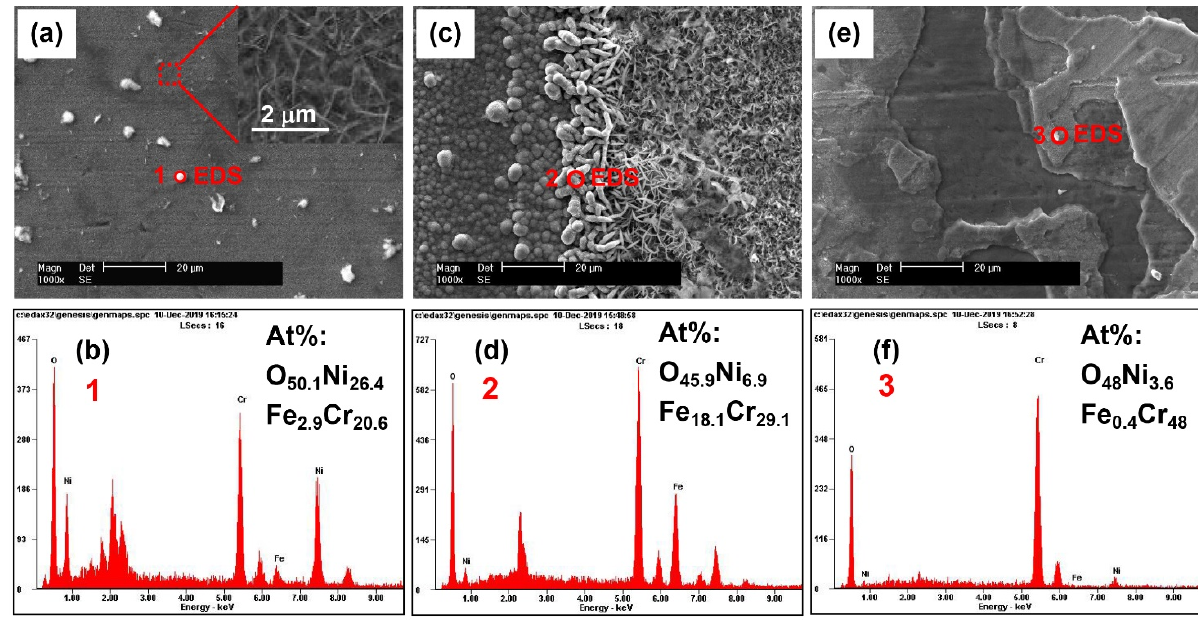
Figure 3. Surface morphology and EDS results of the oxide films formed at different regions of the crevice sample exposed to 290 °C NaCl solution: ( a , b ) outside the crevice, ( c , d ) crevice mouth, ( e , f ) inside the crevice.